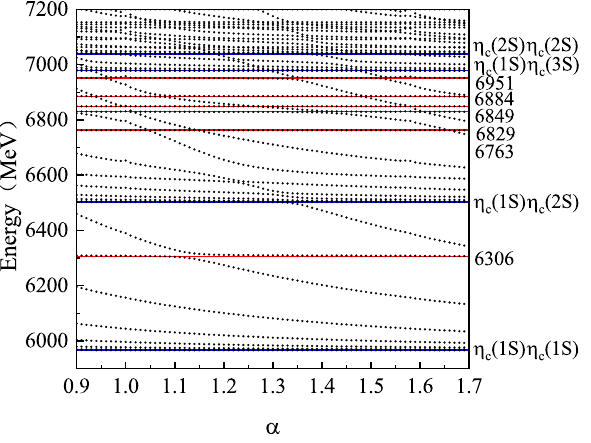
Figure 7. The stabilization plots for the energies of the states for J PC = 0 ++ obtained by considering the coupling between all hidden-color channels and the color-singlet channel ( η c η c ) 0 with respect to the scaling factor α